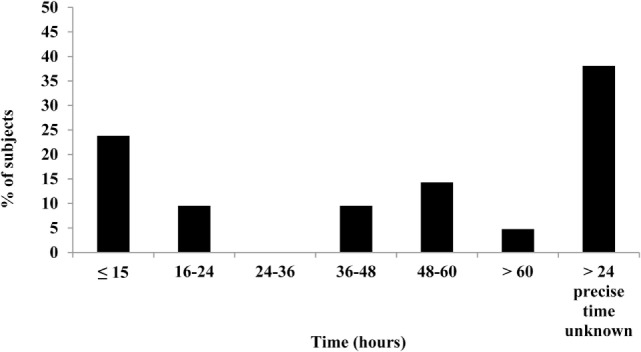
Expulsion times of capsules after ingestion. Complete data available for 21 (out of 24) subjects. Bar chart illustrates the percentage of subjects who expelled the Tc capsule over a period of 13–82 h. Beyond the experimental time period in the laboratory, the precise time of capsule evacuation was unknown for obese subjects (n = 8) and is indicated by the last bar in the chart.